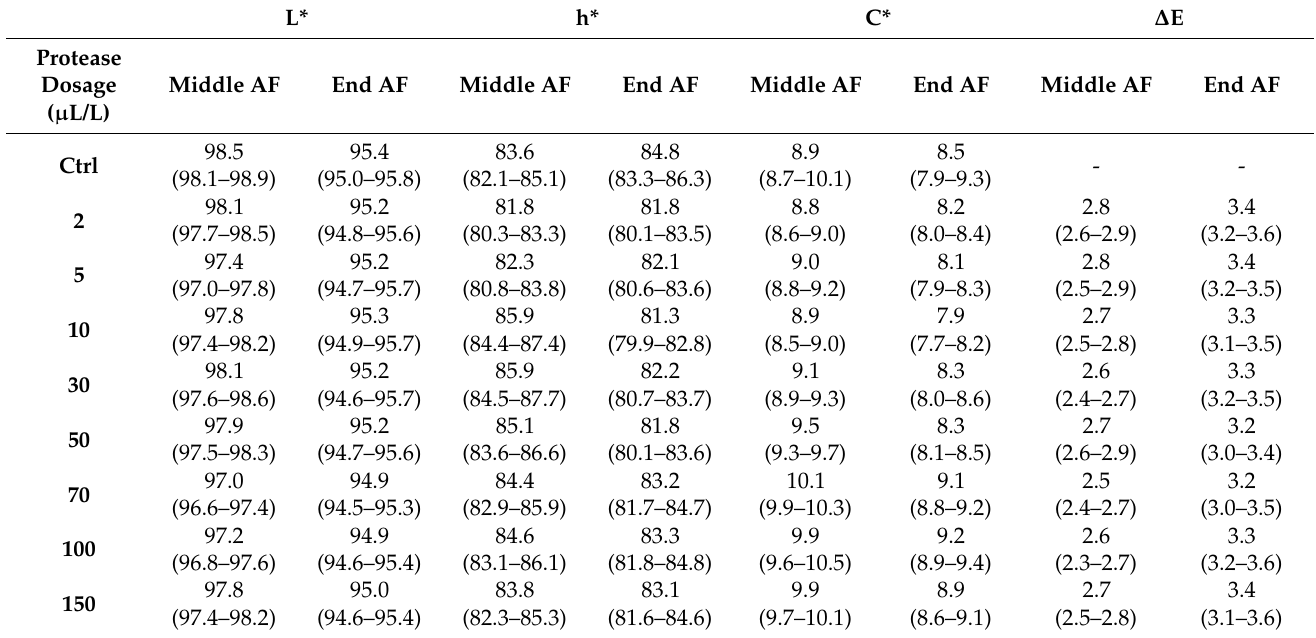
Table 5. Visual color attributes (L*, hue (h*), chroma value (C*) and total color difference ( ∆ E)) of white must wine subjected to enzymatic addition (protease in the range of 2–150 µ L/L) after treatment II (at yeast inoculum, evaluated at middle AF and at the end of AF). Ctrl is clarified must with the only pectinolytic